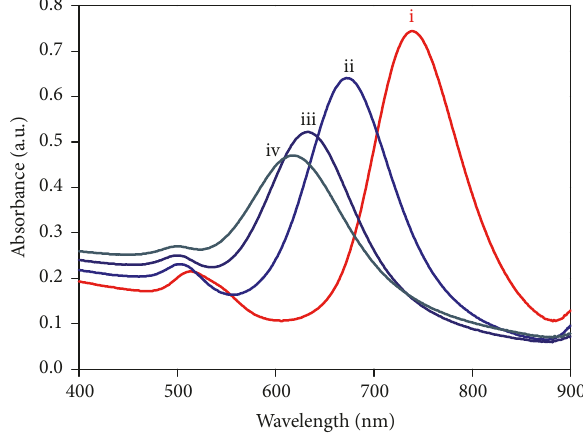
Figure 3: UV-vis absorption spectra of (i) as-prepared AuNRs, (ii) Au-HgNRs-I, (iii) Au-HgNRs-II, and (iv)